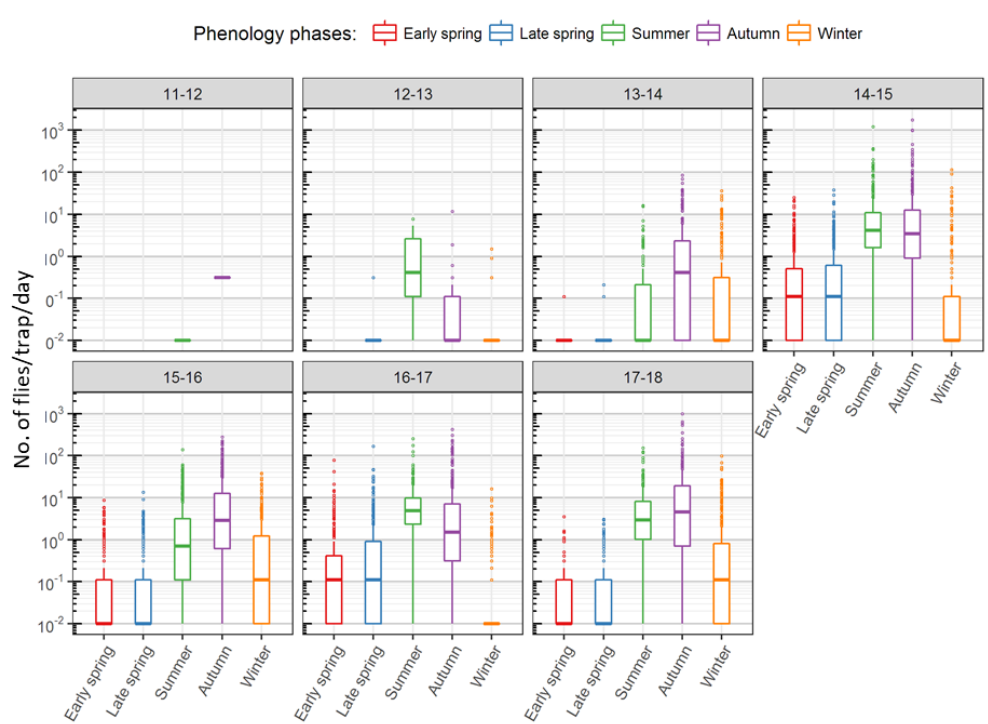
Figure 5. Box plots of captures/trap/day in each D. suzukii -year, grouped by SWD phenology. For a description of the box plots, see Figure 4. Note: the Y-axis is log-scaled (captures/day/trap + 0.01). Five traps with very high capture rates were selected for a detailed analysis of the effects of land use on their capture rates (Figure 6 and Table S1). These traps were located on the borders of the Forest of Odes next to the Rhine valley with the highest captures in 2014–2015 and 2017–2018. Two traps (DO_E21 and DO_E19) were located prominently on a small mountain ledge, close to orchards/vineyards and the forest. Both traps captured between five- and 10-times more individuals over the years than trap DO_E5, which is also close to orchards/vineyards and shrubberies. The trap DO_E1 on the forest border, next to the urban area (Dossenheim) and a quarry captured less individuals than the above-mentioned traps, whereas the trap DO_E2, located deeper in the woods with only trees and no shrubberies nearby, and hence farther than the others from forest borders, orchards or urban areas, captured the lowest numbers.